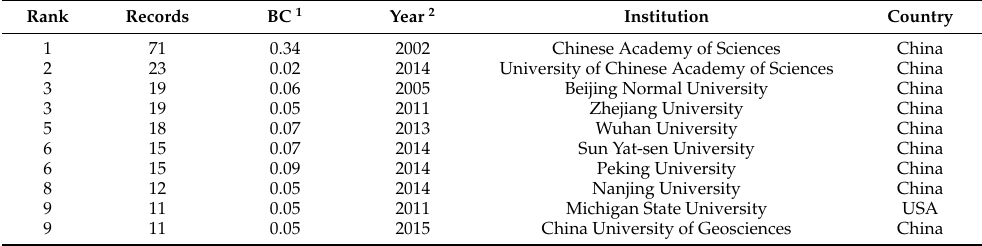
Table 1. Top 10 active institutions.